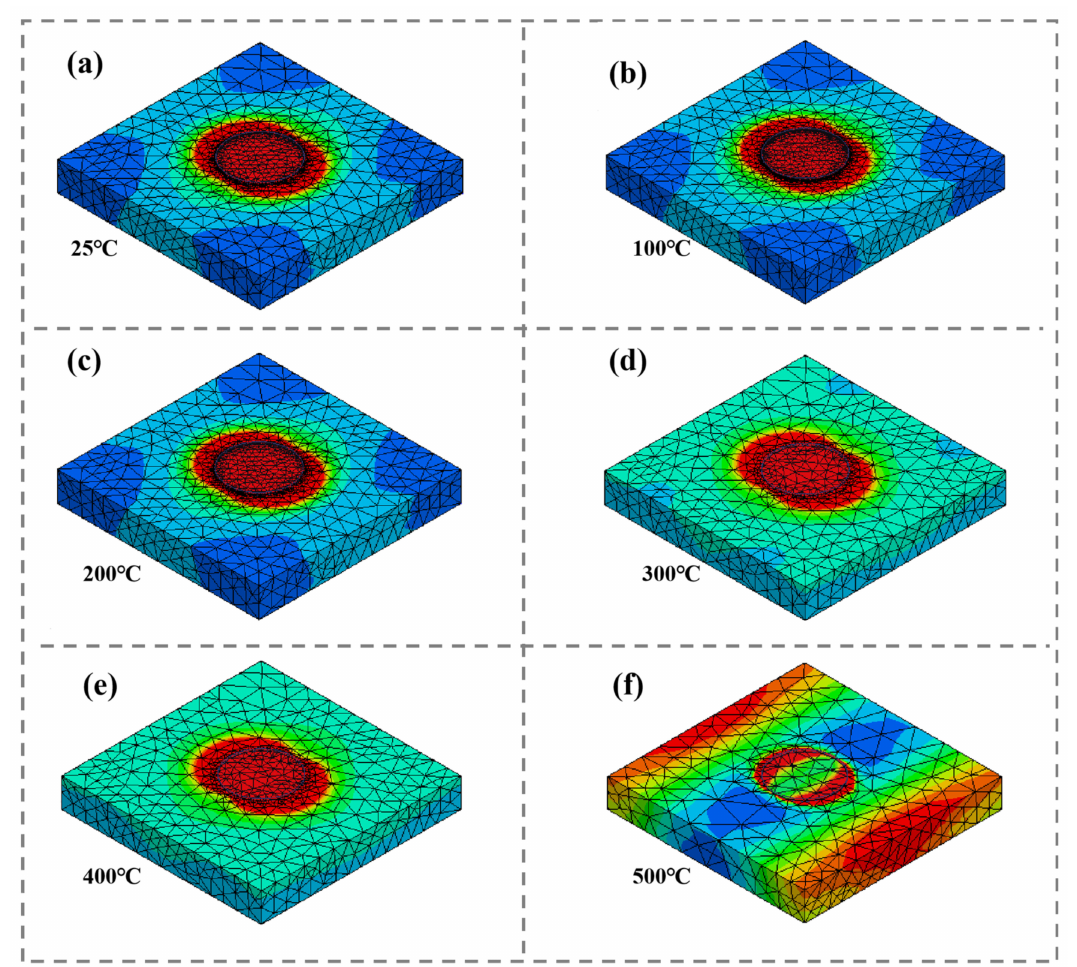
Figure 9. The volume power loss density distribution of RAM at different temperatures. ( a ) 25 ◦